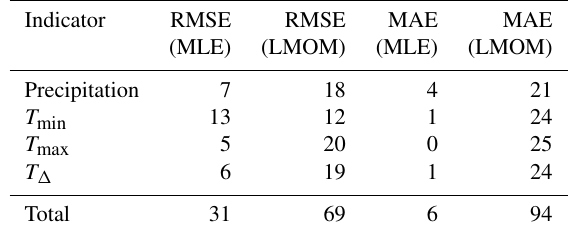
Table 1. Comparison of parameter estimation methods for the AMS approach based on goodness-of-fit measures RMSE and MAE. Numbers indicate success cases of MLE and LMOM.